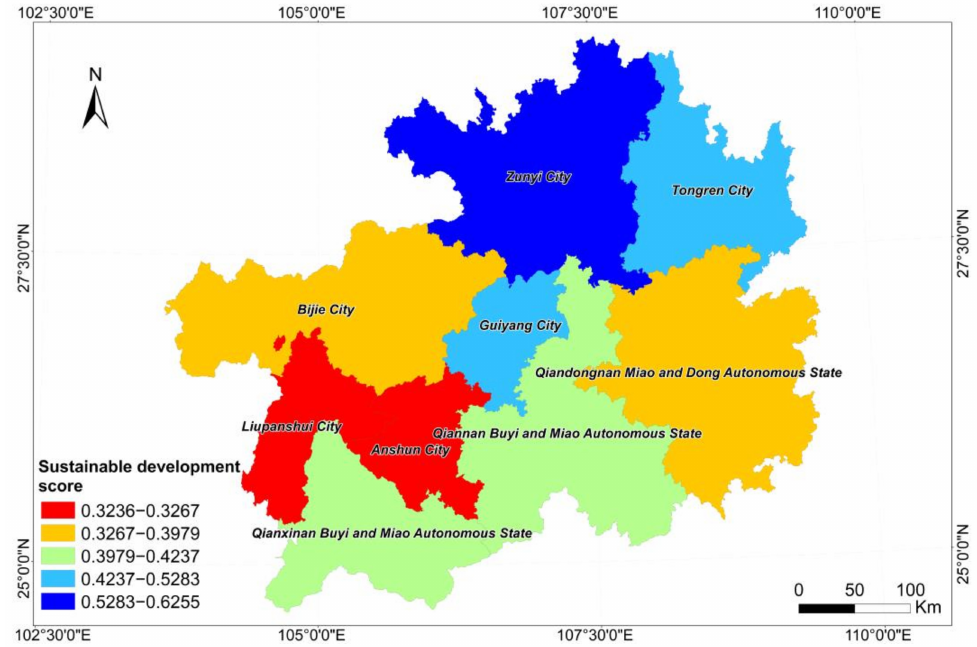
Figure 7. Assessment results of the sustainable development of the terrestrial